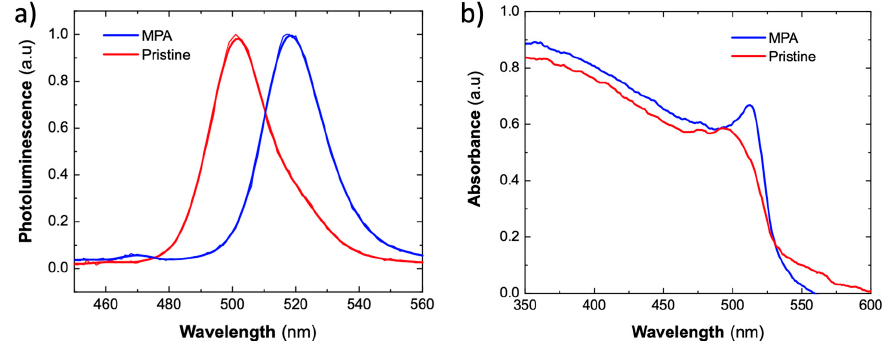
Figure 2. Optical characterization of the 350–400 nm CsPbBr 3 PNCs 400 nm layers before (red curves)